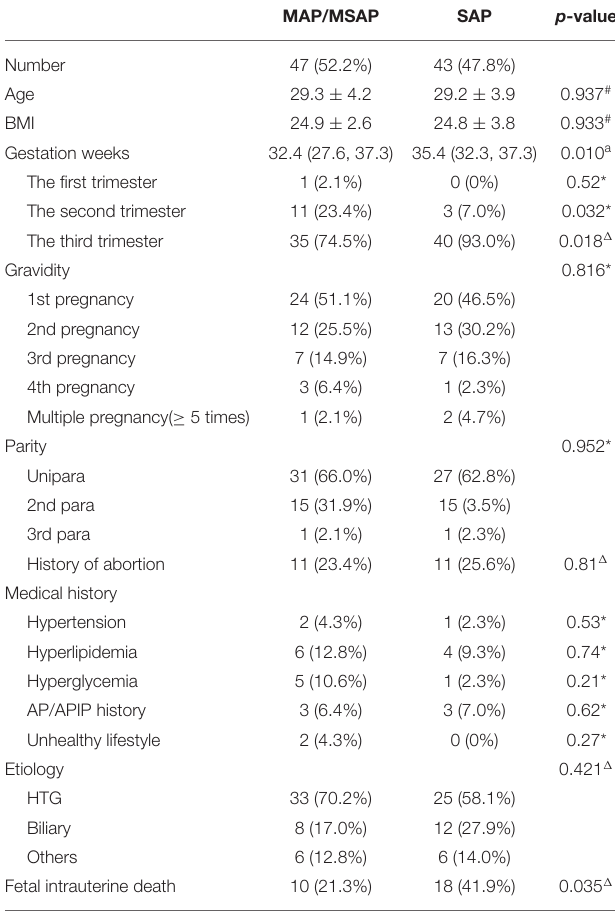
TABLE 3 | Comparison between MAP/MSAP and SAP patients.